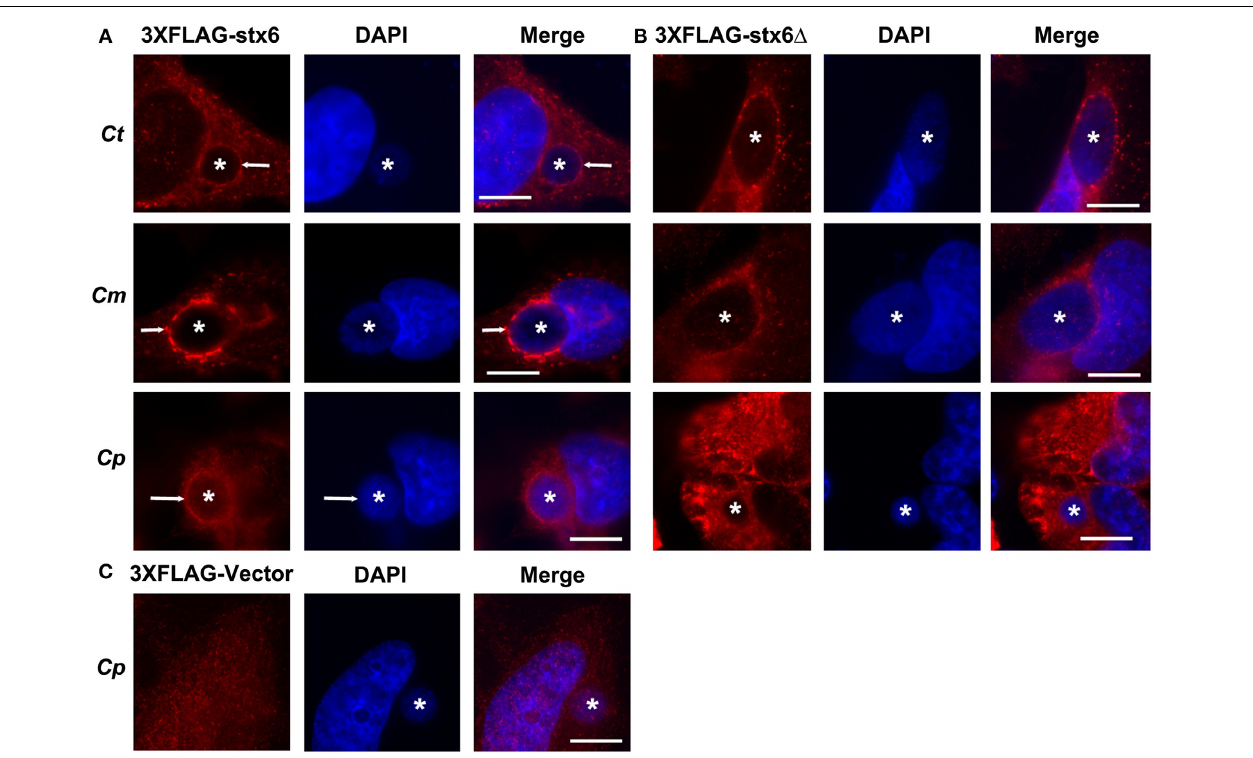
FIGURE 4 | Localization of syntaxin 6 and syntaxin 6 (cid:2) YGRL to different chlamydial species. HeLa cells were transfected with 3XFLAG empty vector (3XFLAG-Vector) (C) , 3XFLAG-syntaxin 6 (3XFLAG-Stx6) (A) , or 3XFLAG-syntaxin 6 (cid:2) YGRL (3XFLAG-Stx6 (cid:2) ) (B) and infected with C. trachomatis serovar L2 ( Ct ), C. muridarum ( Cm ), or C. pneumoniae ( Cp ). The cells were fixed in ethanol after 24h ( Ct and Cm ) or 72h ( Cp ) of